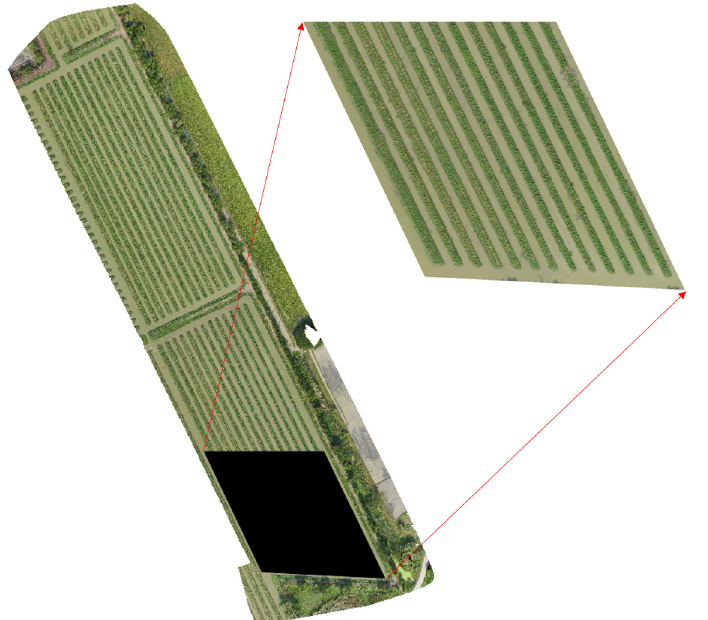
Fig 4. Study area separated into training region and ROI (top